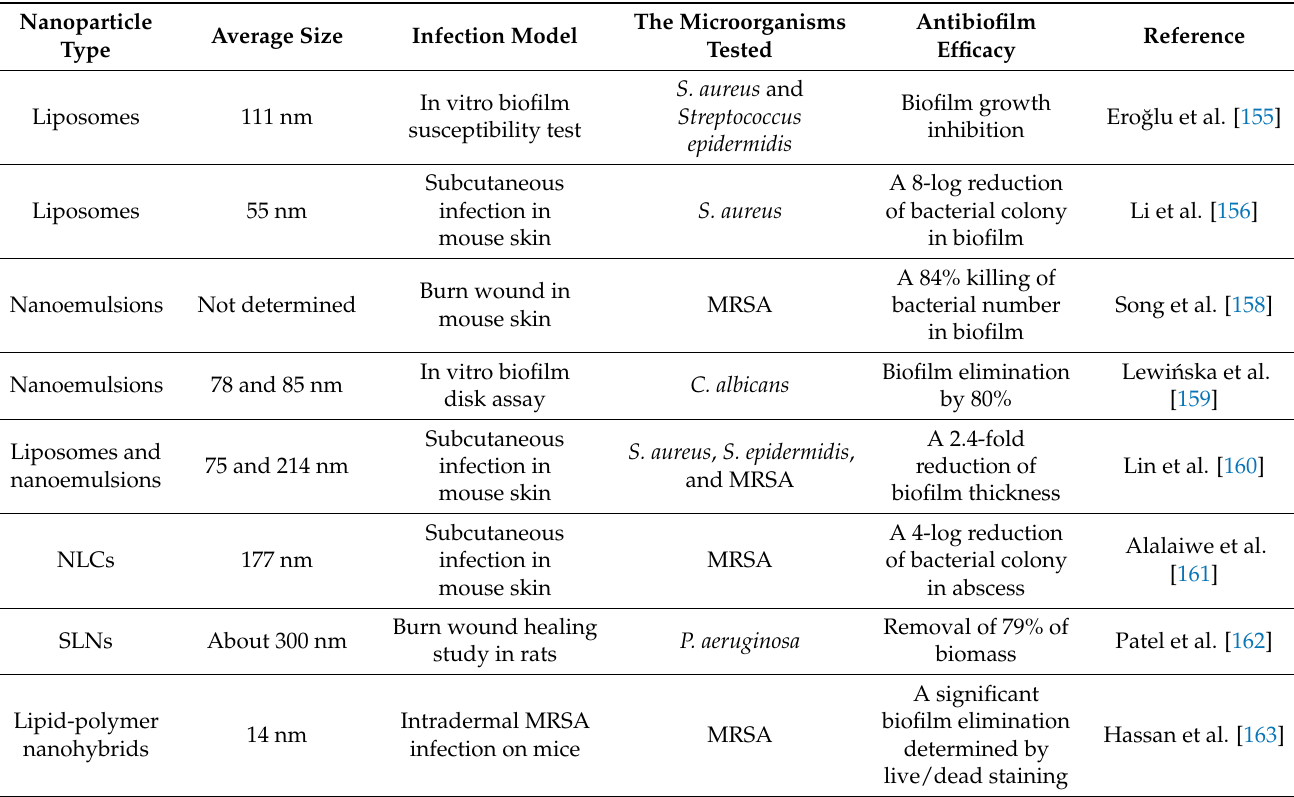
Table 4. The application of lipid-based nanoparticles for antibiofilm